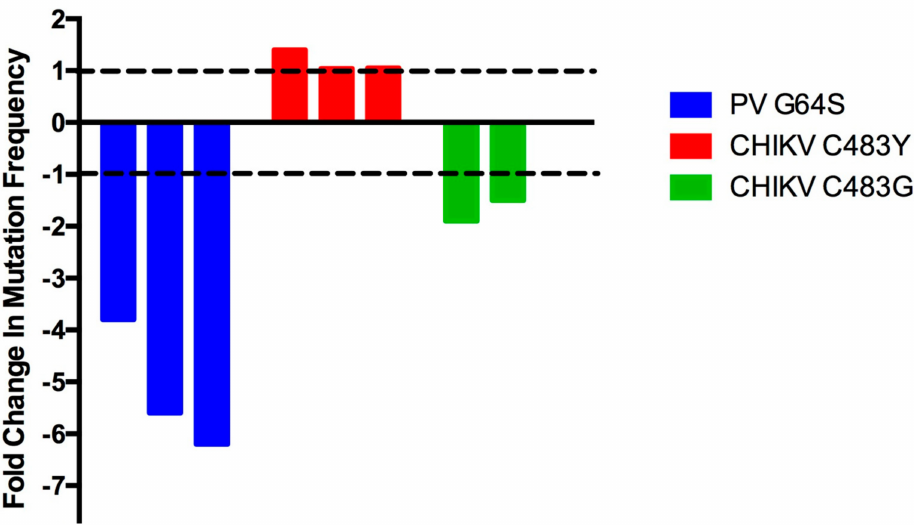
Figure 4. Variation in fidelity mutant mutation frequencies. Variation in the mutation frequency of unaltered virus versus: high-fidelity PV G64S [27,34,35], high-fidelity CHIKV C483Y [44–46], or low-fidelity CHIKV C483G [45,46]. Dashed lines indicate equal levels of mutation frequency for control and fidelity mutant